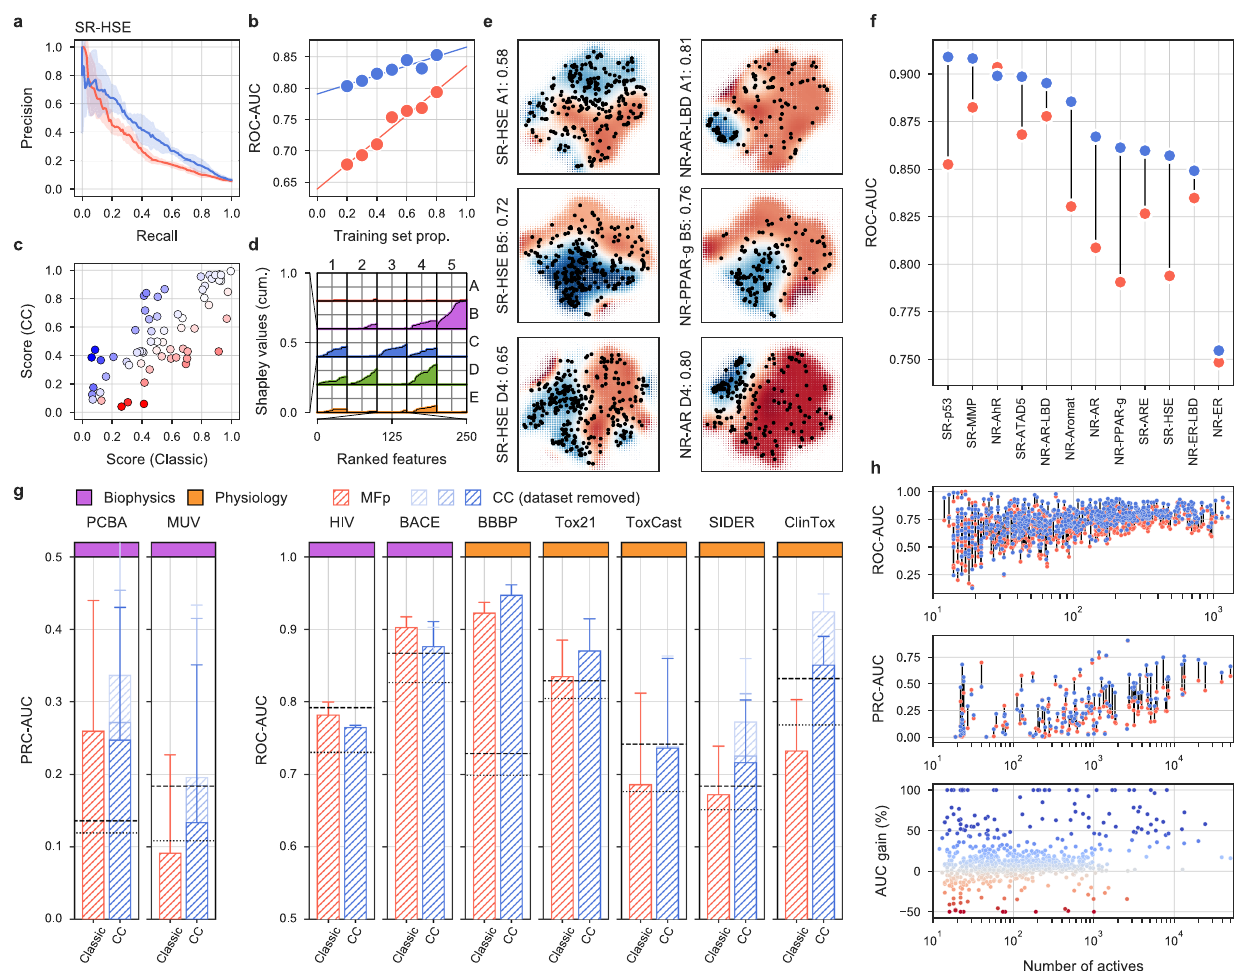
Fig. 5 MoleculeNet benchmarks, comparing the predictive power of CC signatures with a classical MFp-based approach. a Precision – recall curves (PRCs) for the Tox21 SR-HSE task, trained with CC signatures (blue) and MFps (red). Shaded areas span the standard deviation over fi ve strati fi ed train – test splits, the darker lines indicate the mean value. b Robustness of the SR-HSE classi fi er, understood as the maintenance of performance (ROC- AUC) as fewer training samples become available. c Prediction scores (probabilities) of active test molecules using MFps ( x axis) or CC signatures ( y axis). d Importance of CC data sets for the predictions. Features are ranked by their absolute Shapley value (SHAP) across samples (plots are capped at the top 250 features). For each CC data set ( S i ), SHAPs are cumulatively summed ( y axis; normalized by the maximum cumulative sum observed across CC data sets). e 2D projections related to SR-HSE ( fi rst column) and other (second column) tasks, done for the A1, B5, and D4 CC categories (rows). A simple support vector classi fi er (SVC) is trained with the ( x , y )-coordinates as features in order to determine an activity-decision function. Performance is given as a ROC-AUC on the side of the plots. Blue and red areas correspond to likely active and likely inactive regions, respectively. Active compounds are overlaid as black dots. f Performance of CC signatures (blue) and MFps (red) on the 12 Tox21 tasks. Tasks are ranked by their CC ROC-AUC performance. g Global performances of biophysics (purple) and physiology (orange) benchmark tasks. PRC and ROC AUCs are used, following MoleculeNet recommendations, the number of tasks of each category varies and is reported in the original MoleculeNet report. Here we report mean ± SD. Shades of blue indicate whether all 25 CC data sets were used (light) or whether conservative data set removal was applied (darker) (Supplementary Table 1). Dashed and dotted lines mark respectively the best and average reported performance in the seminal MoleculeNet study 13 . h Relative performance of CC and MFp classi fi ers across all MoleculeNet tasks (split by ROC-AUC and PRC-AUC metrics, correspondingly; top and middle panels). Higher performances are achieved when more active molecules are available for training ( x axis). The average gain in AUC is plotted in the bottom